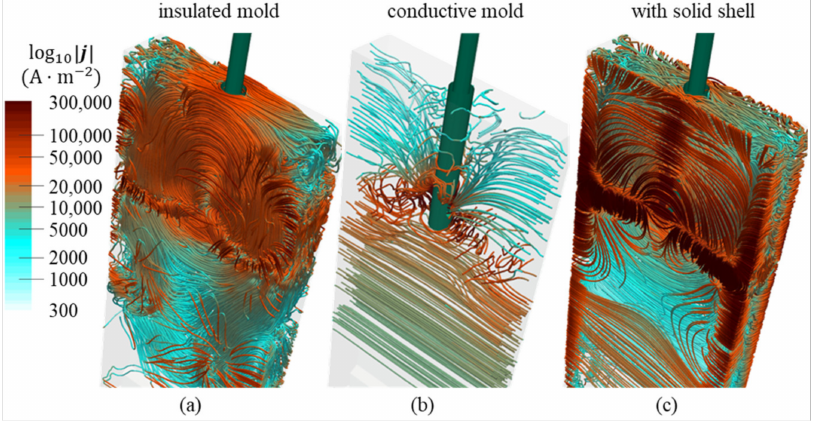
Figure 6. Induced e-current lines distribution: ( a ) fully insulated mold; ( b ) perfectly conductive mold; ( c ) presence of the conductive solid shell. Extracted from Ref. [25]. Reference [25] is available under Creative Commons By Attribution 4.0 in: https://creativecommons.org/licenses/by/4.0/, accessed on 19 February